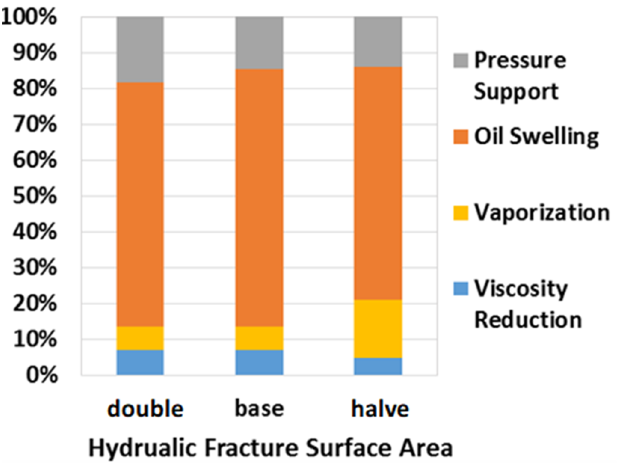
Figure 21. Relative importance of different recovery mechanisms for models with different amounts of fracture surface area.